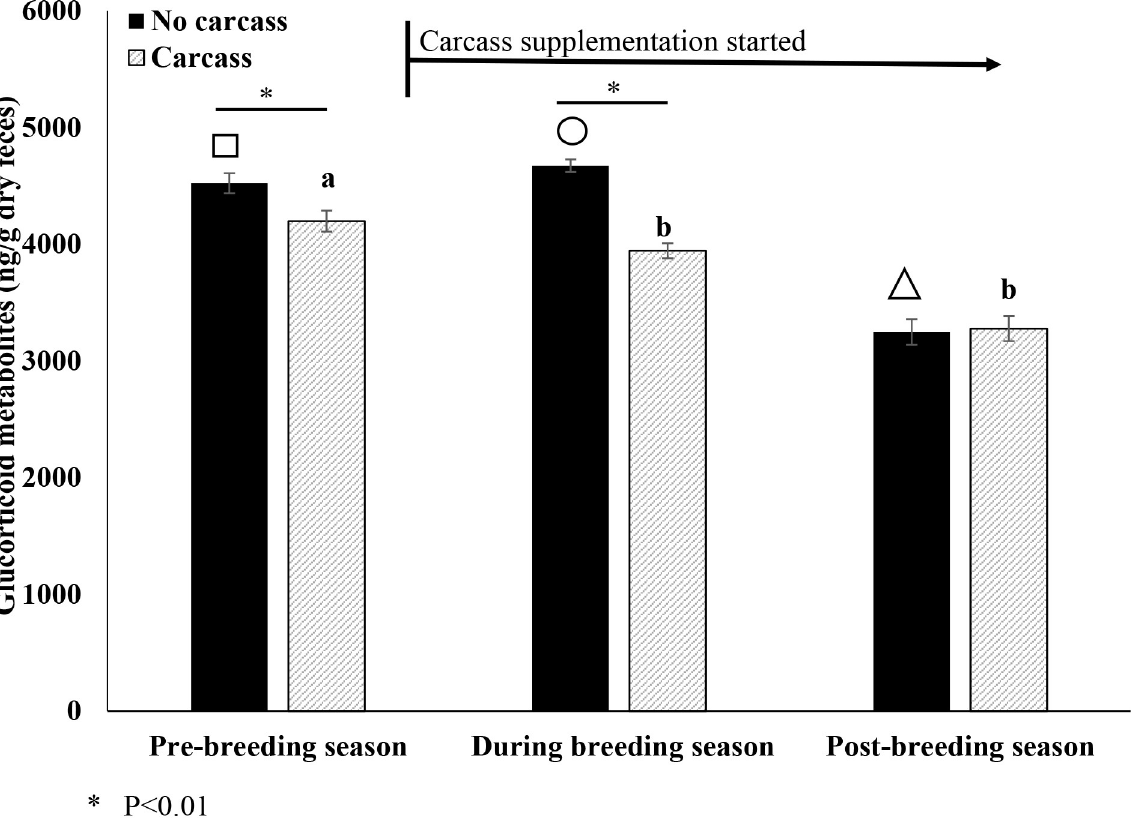
Fig 1. Mean ( ± SEM) fecal glucocorticoid metabolites (FGM) across season (pre-, during and post-breeding season) and treatment (carcass vs. no carcass). Different superscripts (a, b, c) depict differences (P < 0.05) across time in ferrets fed carcass. Different symbols (square, triangle, circle) depict differences (P < 0.05) across time in non-supplemented ferrets. Finally asterisks indicate differences (P < 0.05) between treatments within each time period.